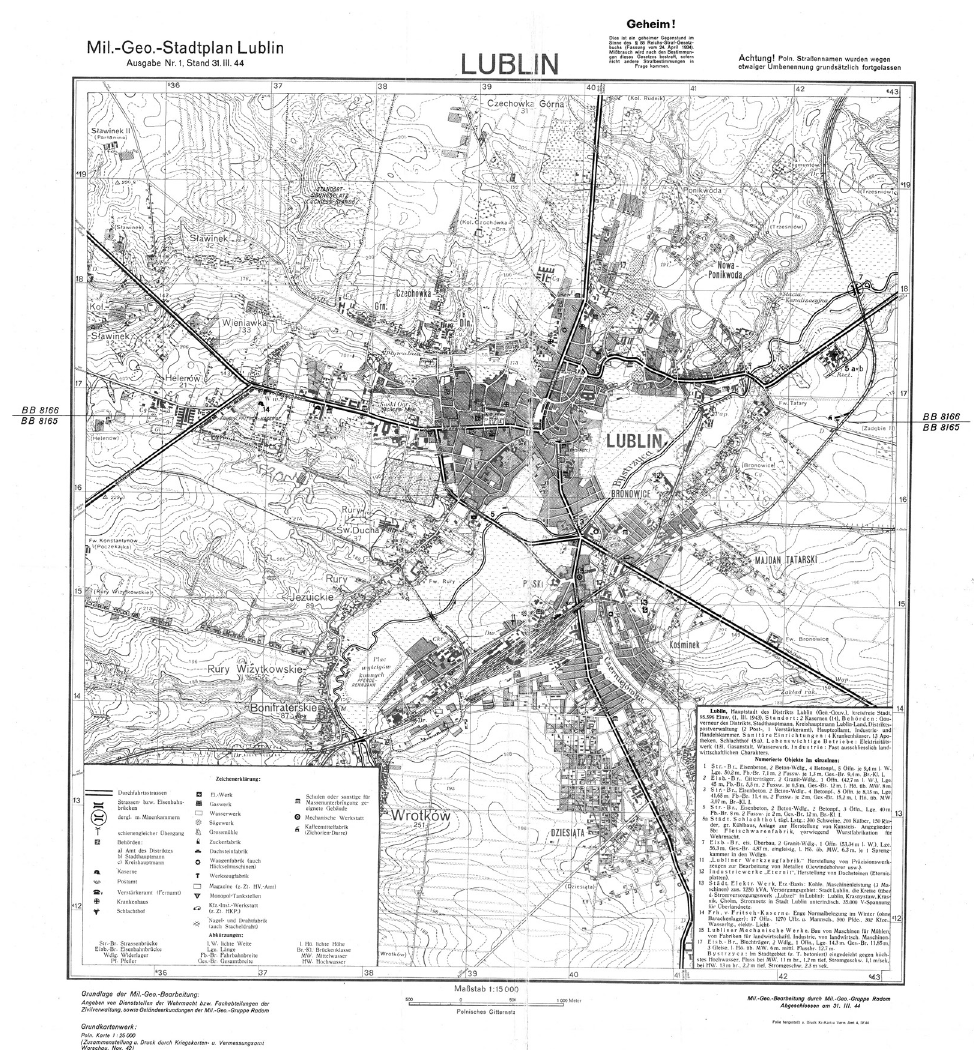
Fig. 6. Militär-Geographische Stadtplan Lublin 1:15,000 (1944), 61 × 63 cm, 22% of original size. The map is based on enlarged 1:25,000 detailed map by the MGI– ‘partially compiled’ sheets P43-S35-H Lublin Północ and P44-S35-B Lublin Południe. Source: Cyfrowa Biblioteka Narodowa POLONA (polona.pl), public